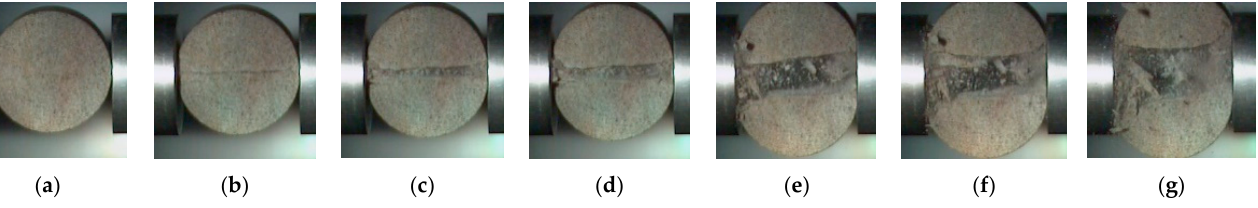
Figure 12. Dynamic tensile crack development process in sandstone under high-speed camera. ( a – g ) Crack extension pattern with time under high-speed camera.